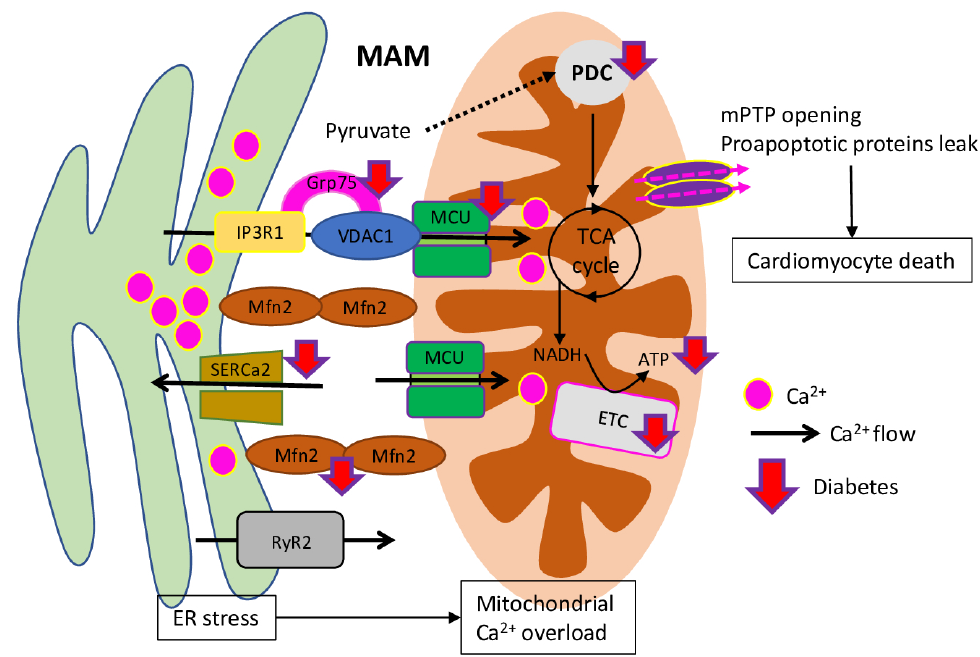
Figure 2. Influence of diabetes on mitochondrial Ca 2+ homeostasis. Diabetes inhibits key players, indicated by red arrows. Mitochondria and ER/SR are linked by several proteins resulting in optimised Ca 2+ flows between these two organelles. GRP75 and Mfn2 serve as anchoring proteins, narrowing the MAMs (mitochondrial associated membranes) space between IP3R2/VDAC and RyR2. The mPTP opening can be induced by increased ROS, Ca 2+ or decreased ΔΨm, which is resulting in the release of the mitochondrial content including pro-apoptotic proteins. Abnormal expression of proteins of the MCU results in diminished Ca 2+ uptake with reduced [Ca 2+ ] m . This [Ca 2+ ] m reduction contributes to the occurrence of mitochondrial dysfunctions, in particular, a decrease in the PDC activity, followed by decreased mitochondrial bioenergetics. Consequently, the insufficient ATP content cannot match the energy demand for the cardiomyocyte contraction required for the normal functioning of the heart.